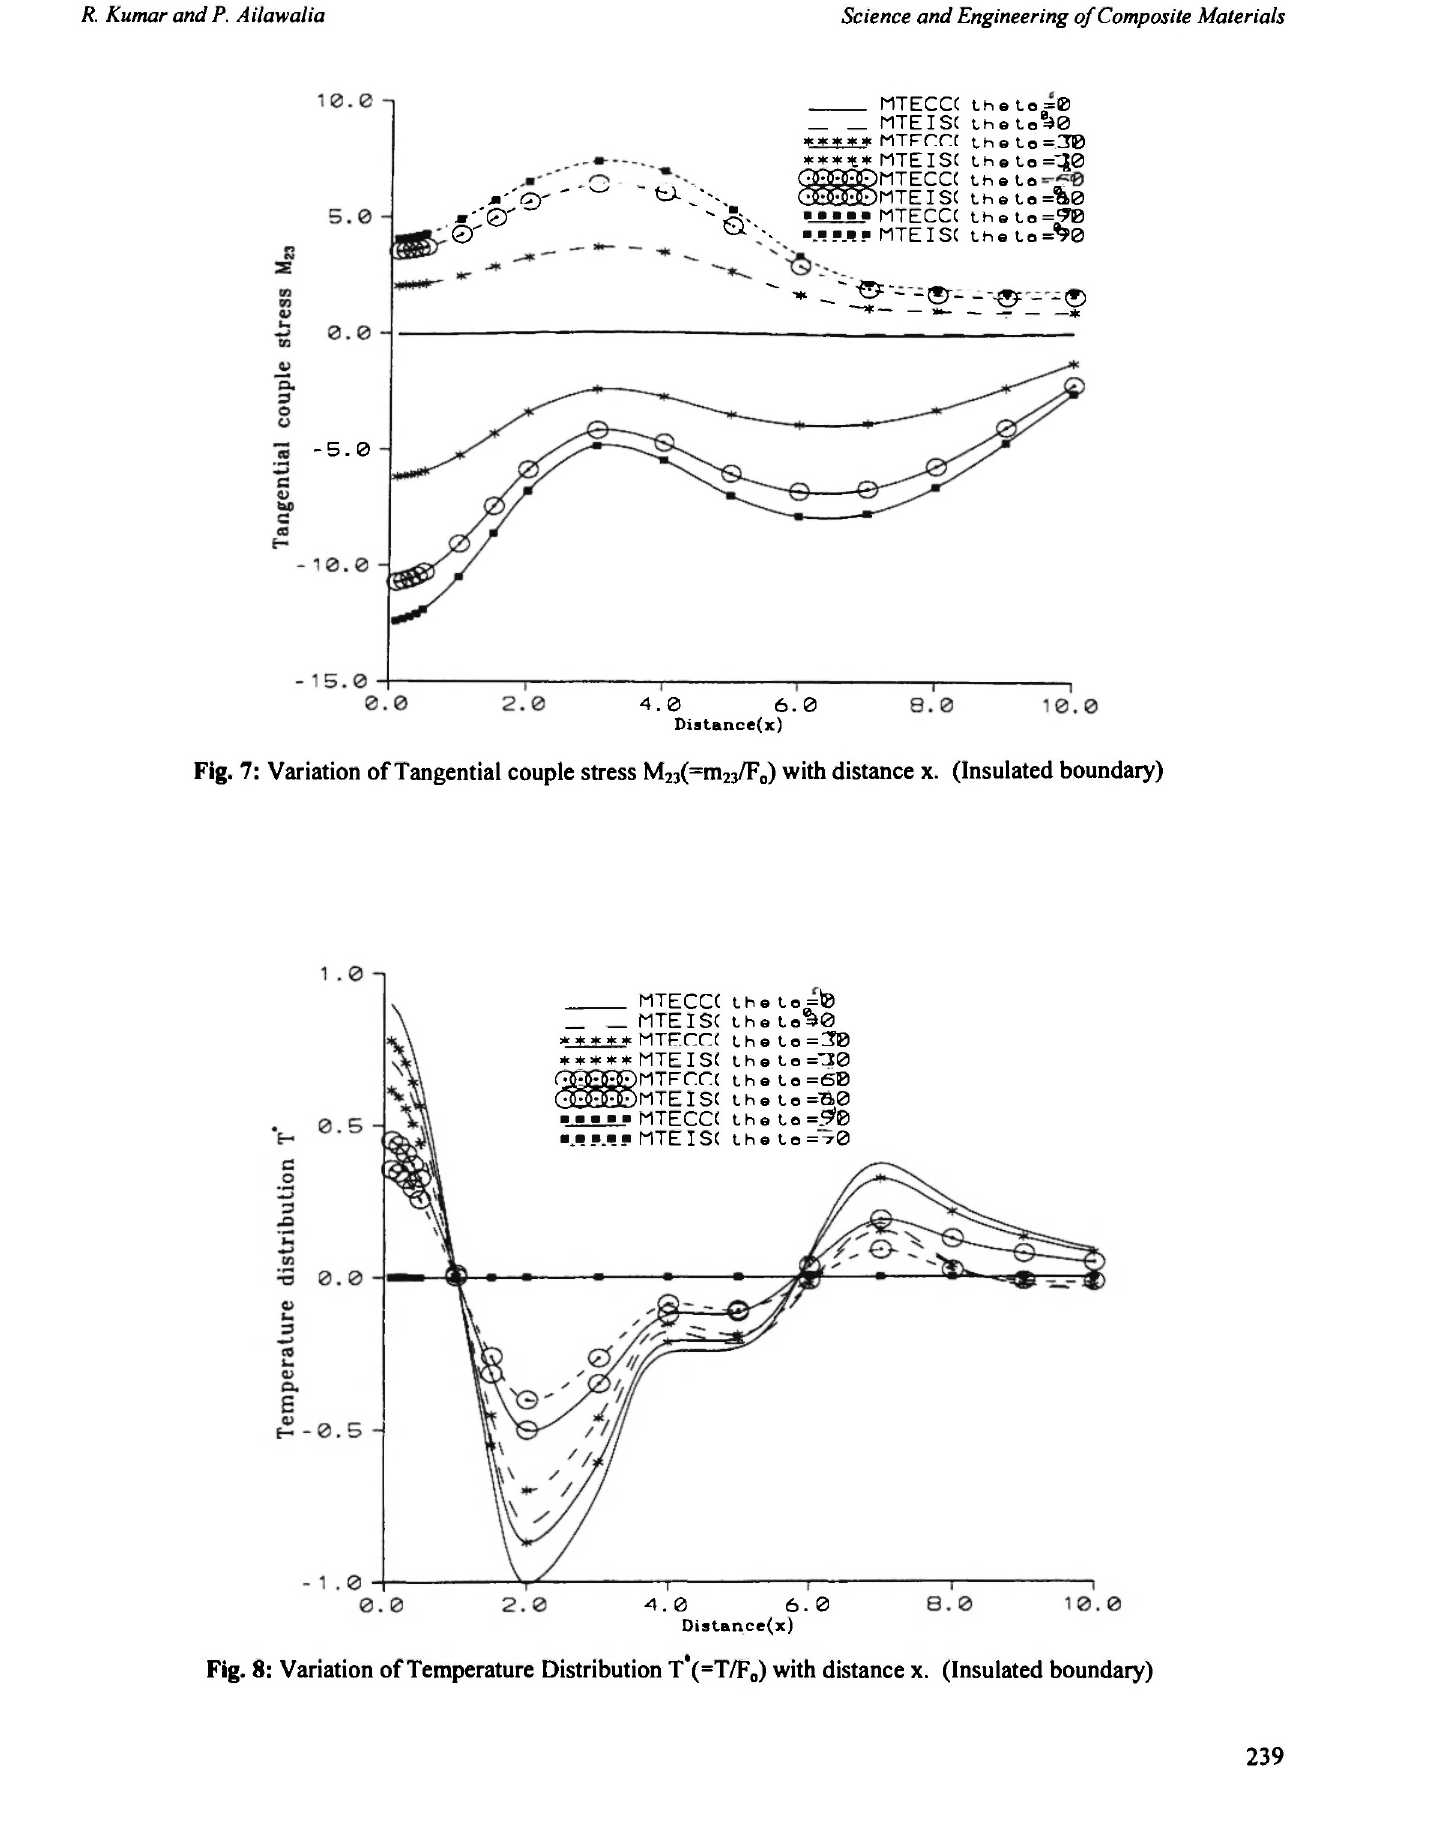
Fig. 8: Variation of Temperature Distribution T*(=T/F 0 ) with distance x. (Insulated